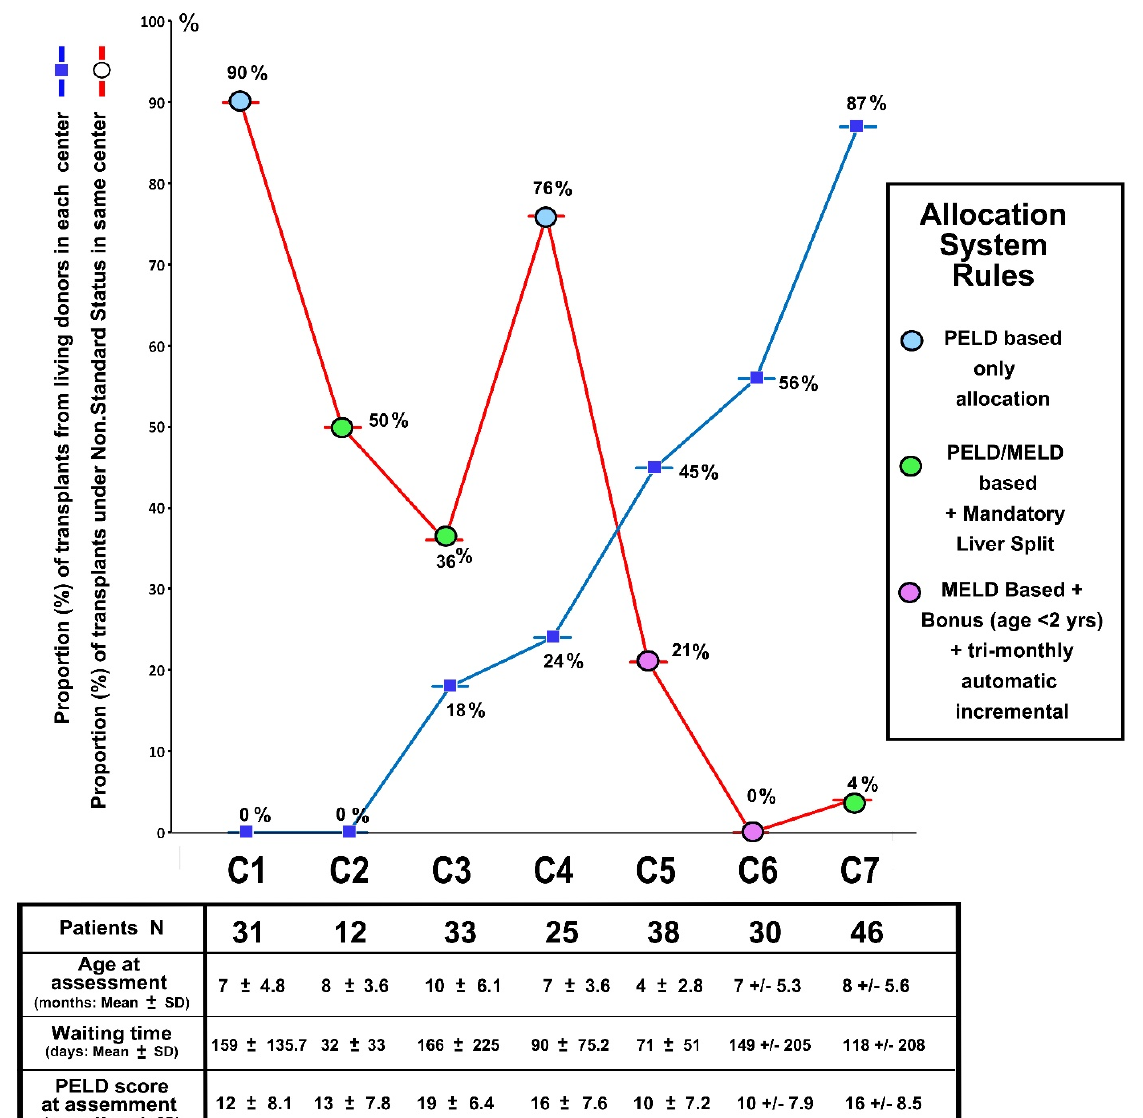
Figure 1. Waiting list dynamics in 7 centers participating in organ sharing/allocation system and use of PELD exception or priority status for timely transplants. Specific waiting list data from 7 separate centers (C1 to C7). 1—Age, weight and PELD score at the time of patient assessment for liver transplantation (bottom table: values given as mean ± SD) (all mean values were rounded to the nearest integer), and 2—proportion (%) of transplants performed in each center using a living related donation (blue line and dark blue spot ) and a request for a PELD exception or similar priority score (red line) (values in % of all transplants in each center). Center organ sharing/allocation system type (see legend on the right side) are referred to as per the color spot in the figure (blue, green and purple).